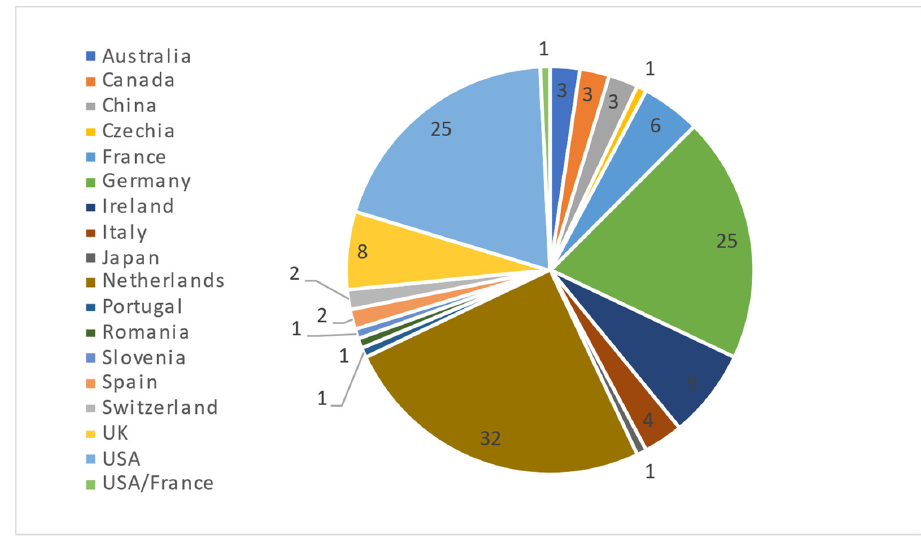
Figure 1. Distribution of Authors by Country.